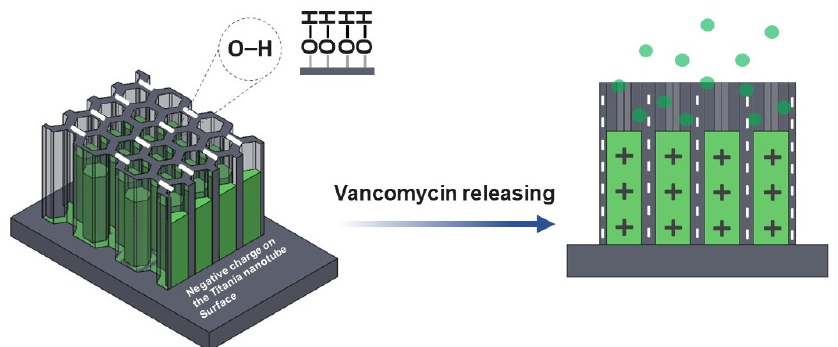
Figure 8. The model of vancomycin release is proposed. The hydroxyl group (OH) and other functional hydrophilic group from the ATR-FTIR characterization donated by negatively charge ions is attributed to the nanotube surface after anodization.